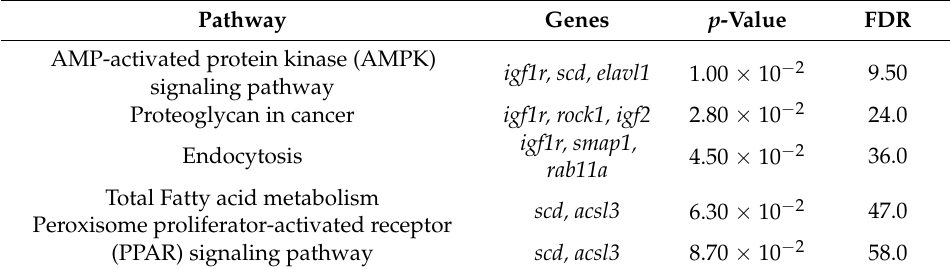
Table 4. Identified signaling pathways and related